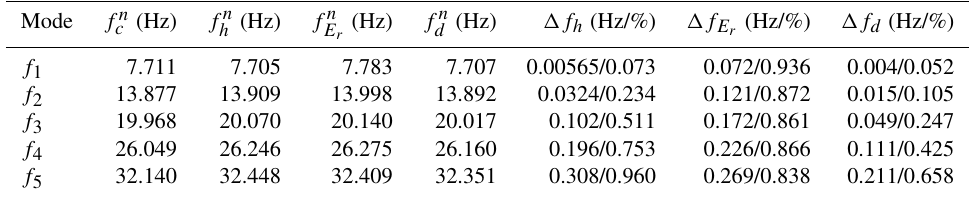
Table 4. Resonance frequencies for the conductivity profile shown in Fig. 2 calculated by different approaches described in Sect. 4, and the relative error obtained by comparison with the analytically obtained resonance